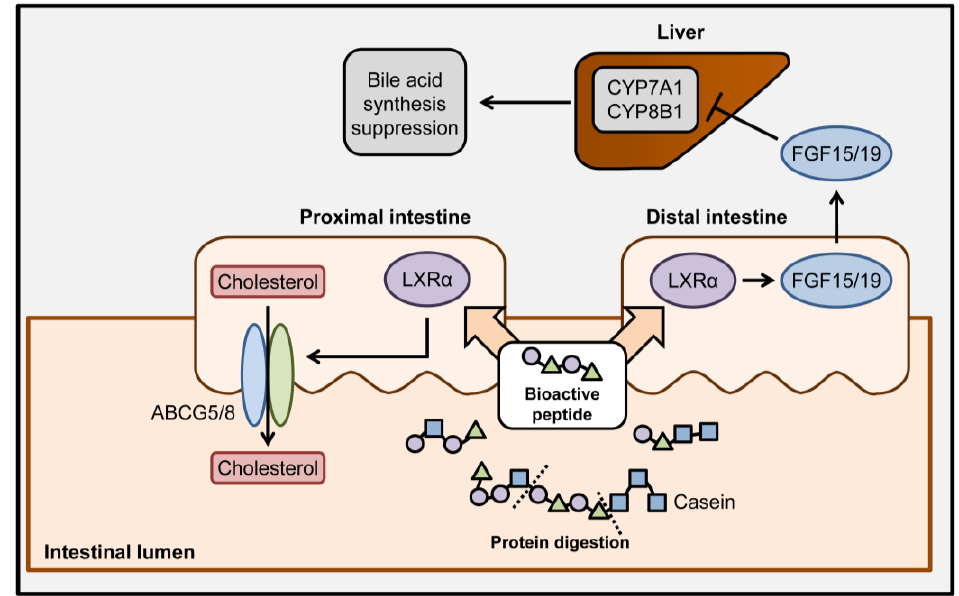
Schematic summary of hypolipidemic effects of casein-derived bioactive peptides. After dietary uptake of casein, the generation of bioactive peptides and its related biological events were depicted. Bioactive peptides derived from the enzymatic digestion of casein enhance ABCG5/8-mediated TICE in proximal intestine and increase FGF15/19 secretion through LXRα signaling activation. Ileal FGF15/19 circulates and suppresses the hepatic expression of CYP7A1 and CYP8B1, resulting in the suppression of hepatic bile acid synthesis.